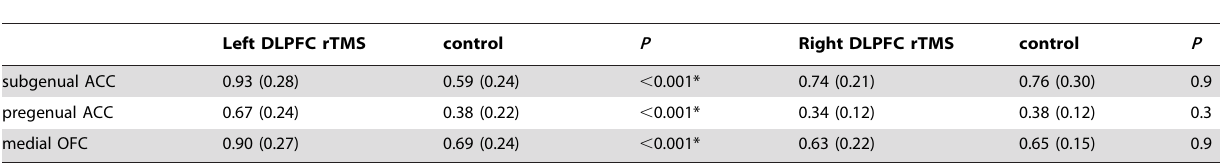
Table 2. Mean [ 11 C]FLB 457 BP changes in prefrontal regions following left and right DLPFC.